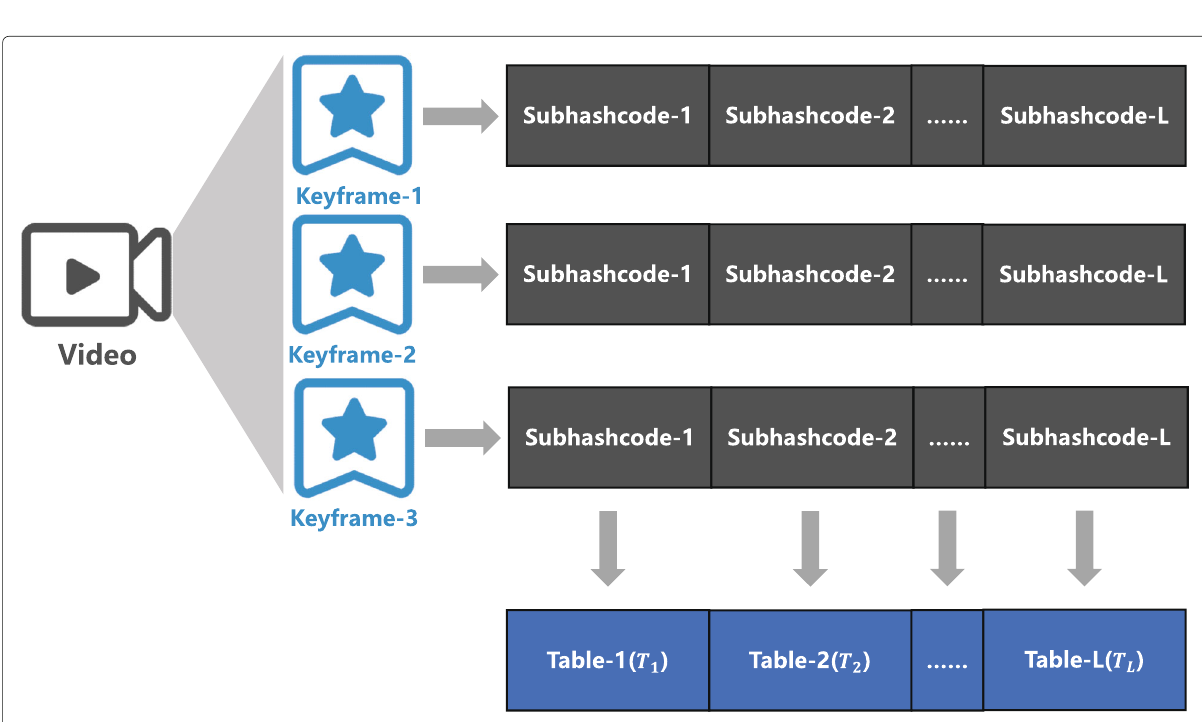
Fig. 5 Overview of the online video